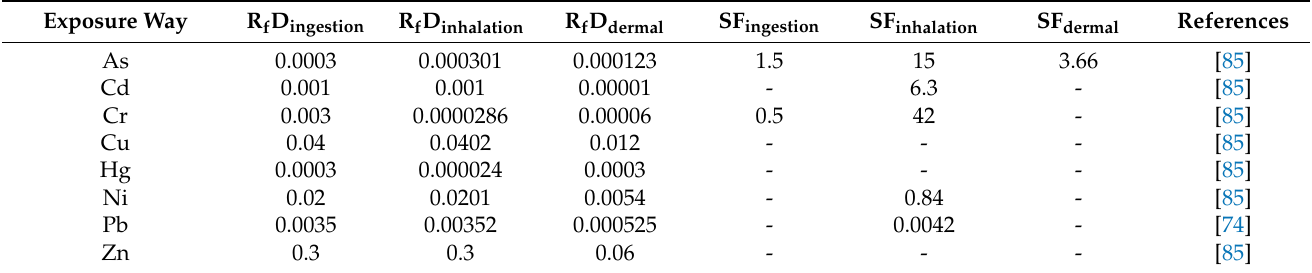
Table 2. The reference dose and slope factor for each PTE and exposure